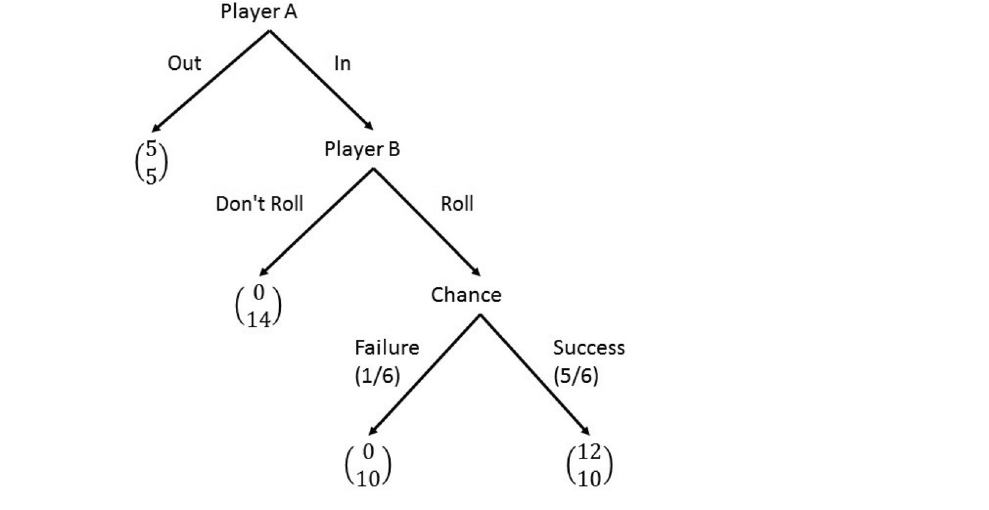
Figure 2. The game.